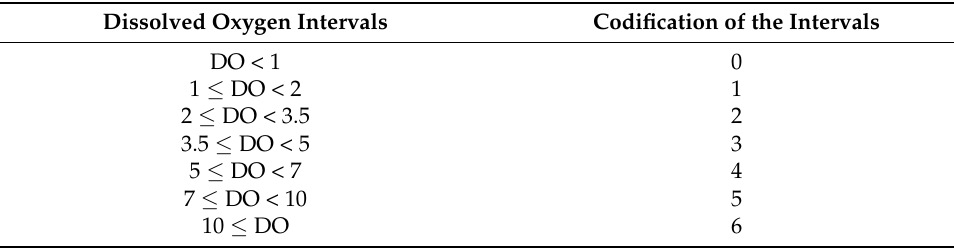
Table 2. Dissolved oxygen discretisation.